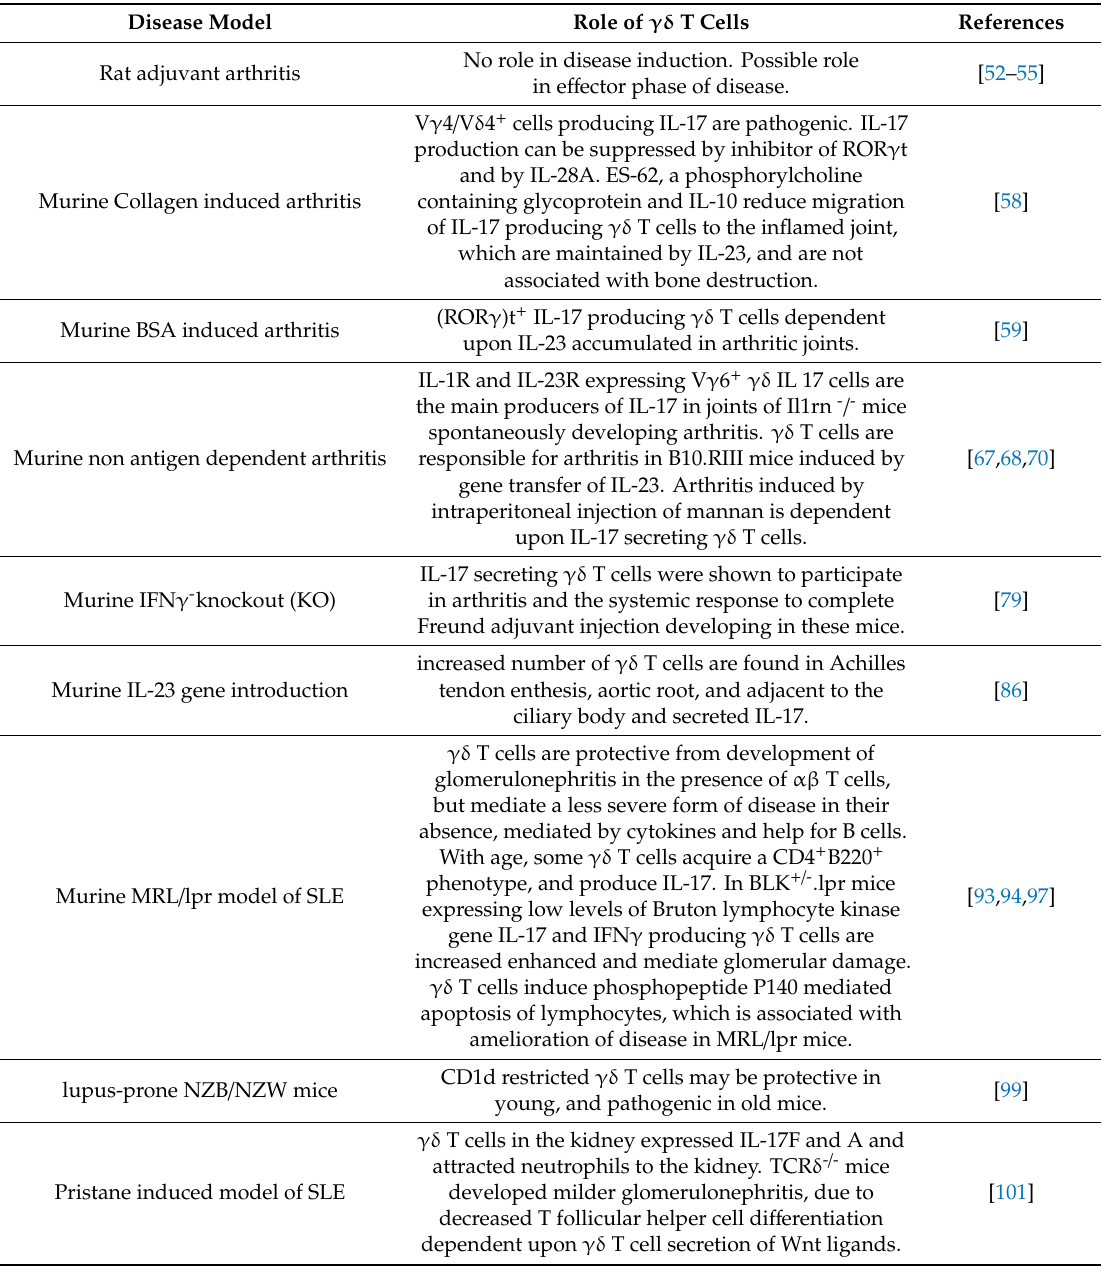
Table 2. γδ T cells in animal models of autoimmune rheumatic